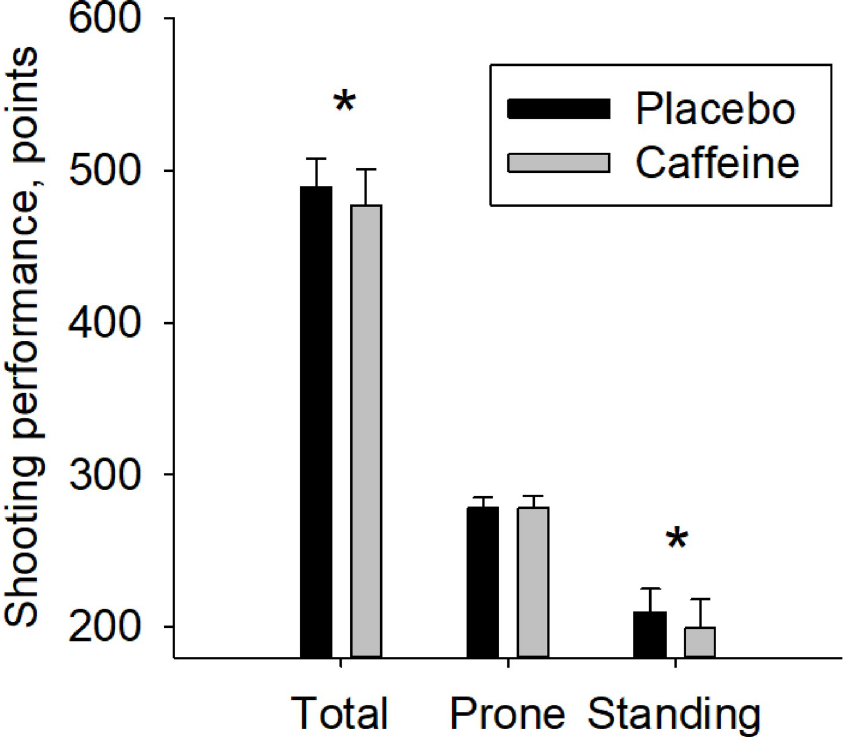
Fig 2. Effect of caffeine on shooting performance in function of shooting position. Total results and separate results from the shooting in prone and standing position with prior ingestion of placebo or caffeine. Mean ± standard deviation. � = p < 0.001 for the difference between placebo and